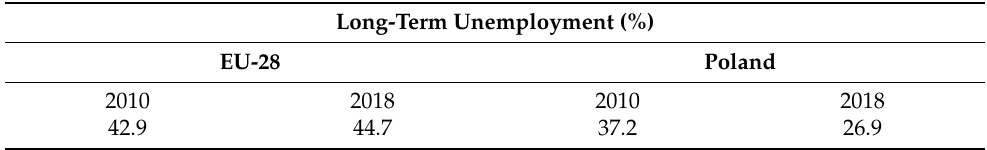
Table 2. Long-term unemployment in EU and Poland